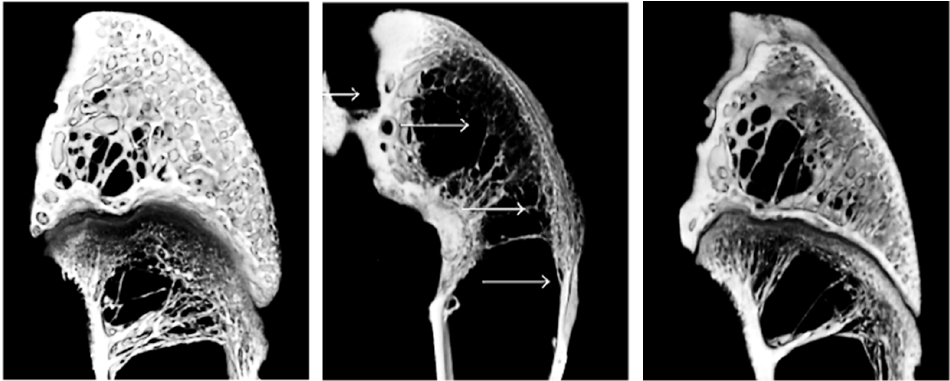
Figure 10. Micro-computed tomography graphs taken after 12 days of implantation of unloaded ( middle ) and VAN loaded ( right ) HAp/Col/calcium sulfate implants. White arrows indicated the tissue destruction in different places of the rabbit femoris. A normal femoris bone is shown on the ( left ). Reproduced with permission from